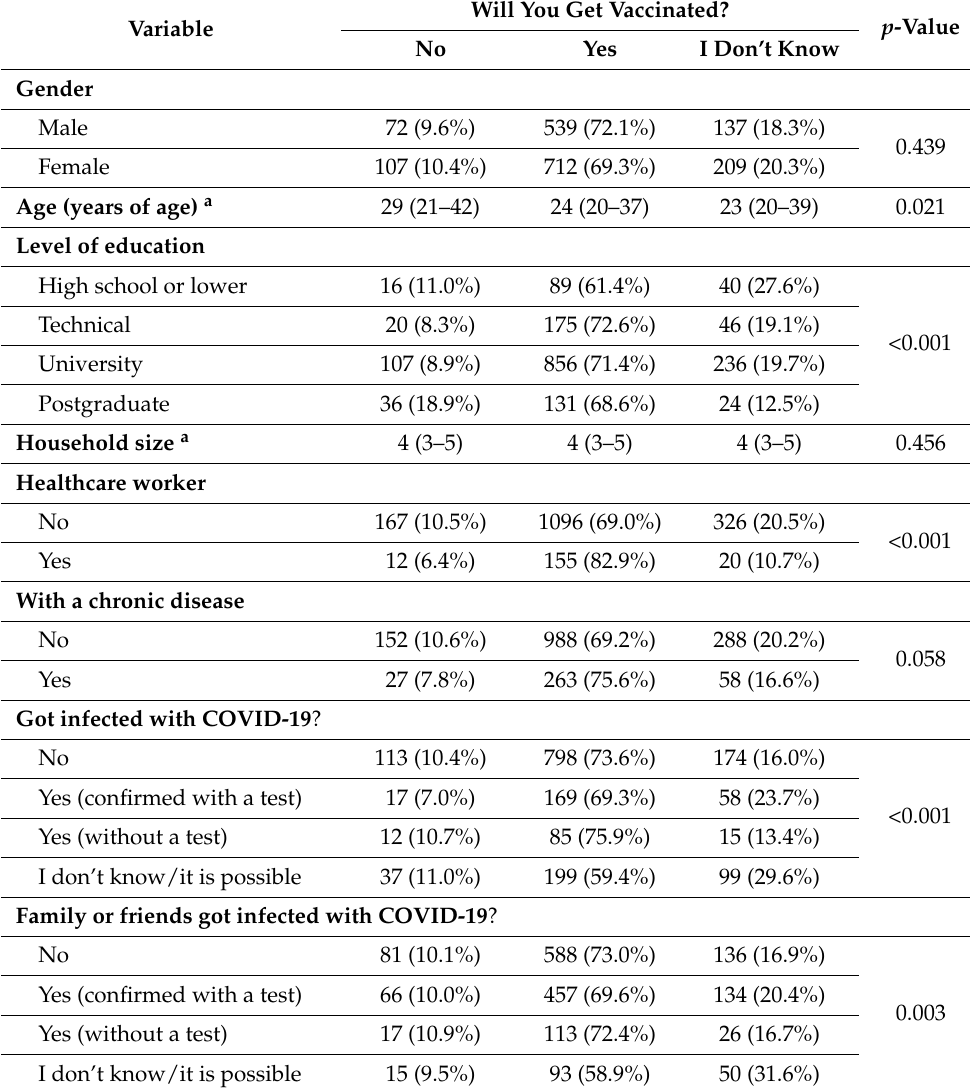
Table 2. Bivariate analysis of sociodemographic characteristics and the intent to get vaccinated against COVID-19 in Peru.